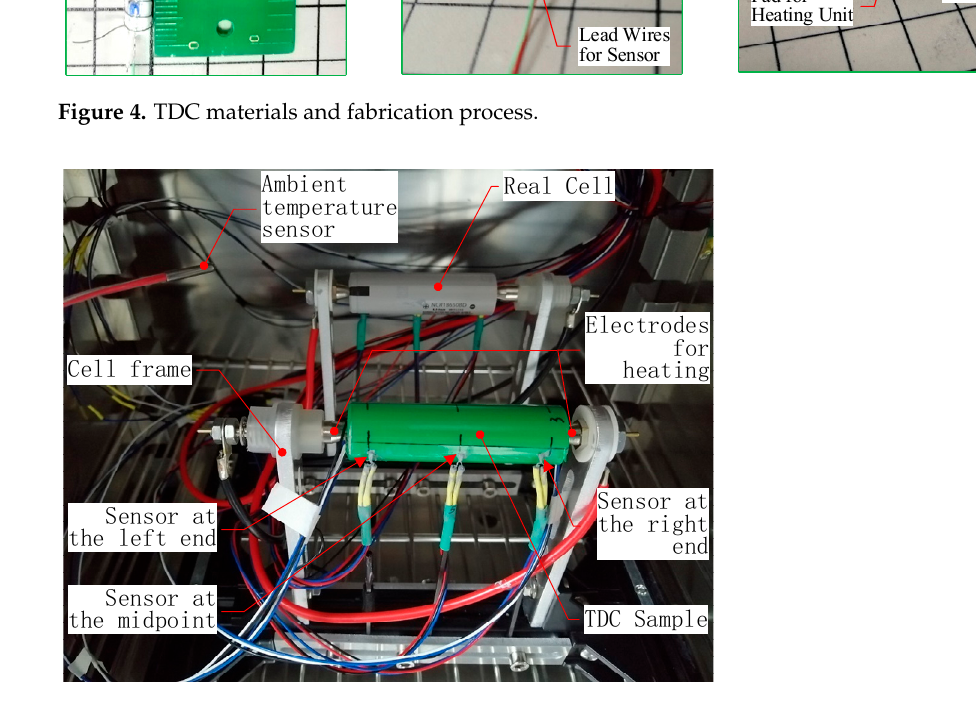
Figure 5. Experimental setup.